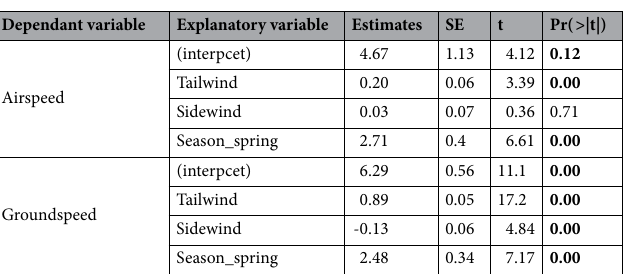
Kites may be strong, forming the uniform behaviour of tracked birds from both studied subpopulations. What is more, our result showing a different genetic history of both populations supports our assumption.